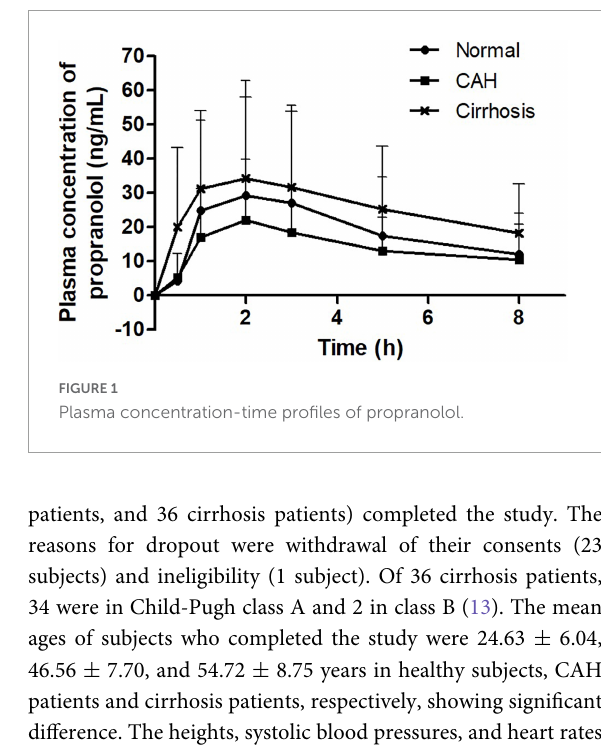
patients, and 36 cirrhosis patients) completed the study. The reasons for dropout were withdrawal of their consents (23 subjects) and ineligibility (1 subject). Of 36 cirrhosis patients, 34 were in Child-Pugh class A and 2 in class B (13). The mean ages of subjects who completed the study were 24.63 ± 6.04, 46.56 ± 7.70, and 54.72 ± 8.75 years in healthy subjects, CAH patients and cirrhosis patients, respectively, showing significant difference. The heights, systolic blood pressures, and heart rates were also significantly different among the groups. The baseline characteristics are presented in Table 1 .